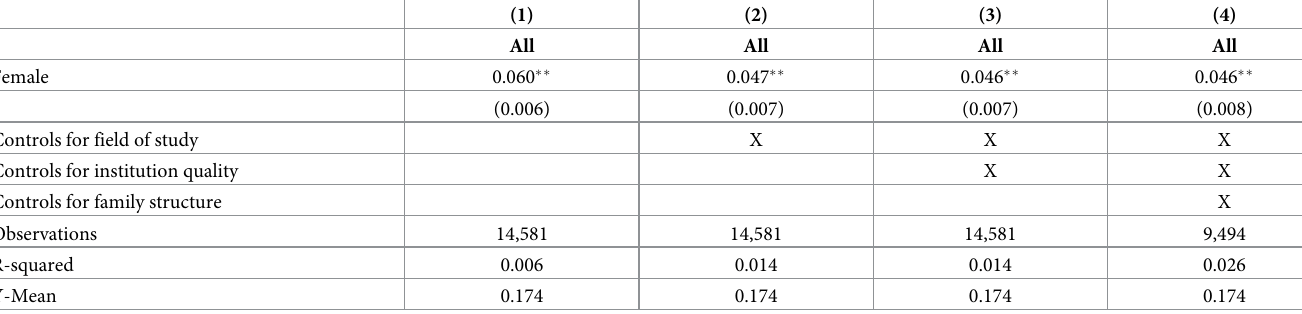
Table 3. Regression-adjusted difference in the share of men and women in non-tenure-track academic